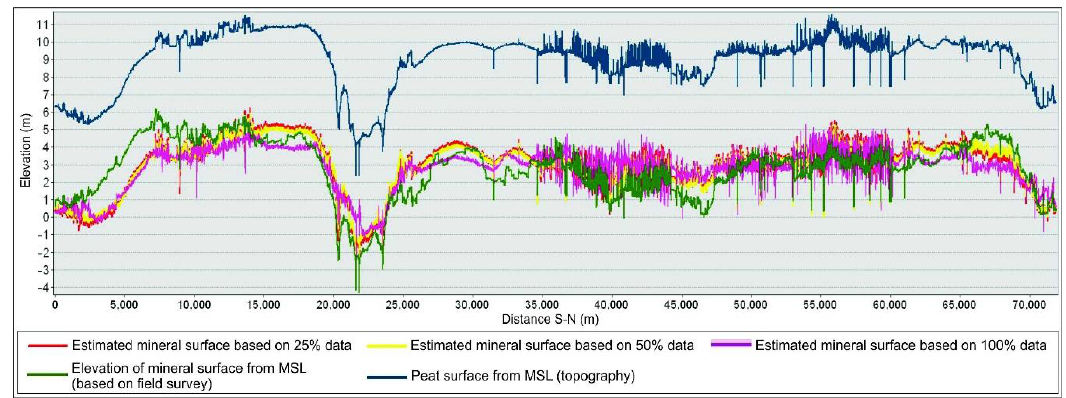
Figure 8. Longitudinal profile of the estimation results of mineral soil elevation based on 25%, 50%, and 100% of data, which are overlaid onto the peat surface topography and the real mineral soil elevation.